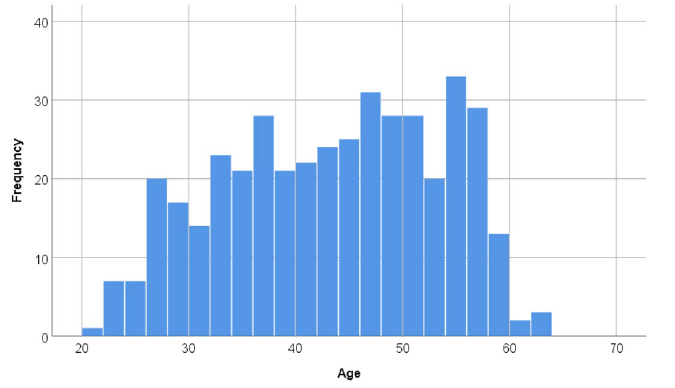
Figure 1. Distribution of